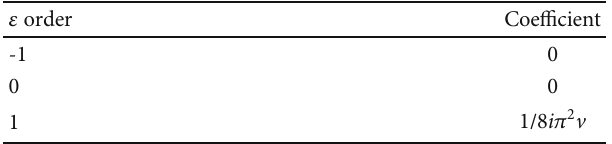
Table 2: A 2 ε series ½ 1, 1 (cid:3) .